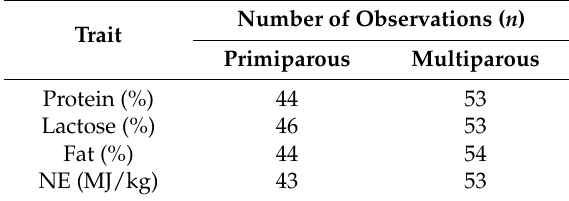
Table 1. Number of observations ( n ) for each trait (including all timepoint observations) for each parity